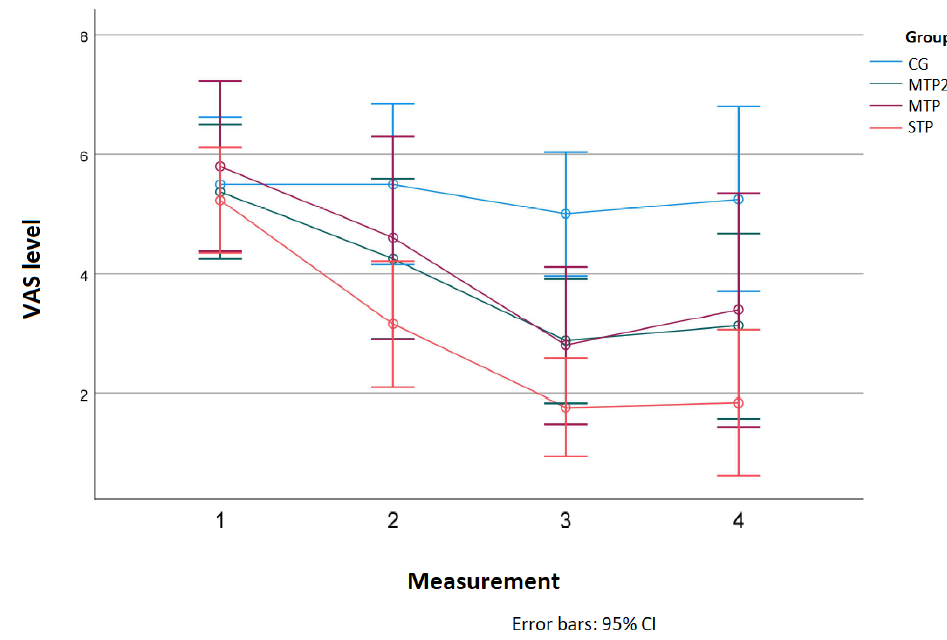
Figure 4. VAS levels in particular groups at subsequent measurements.